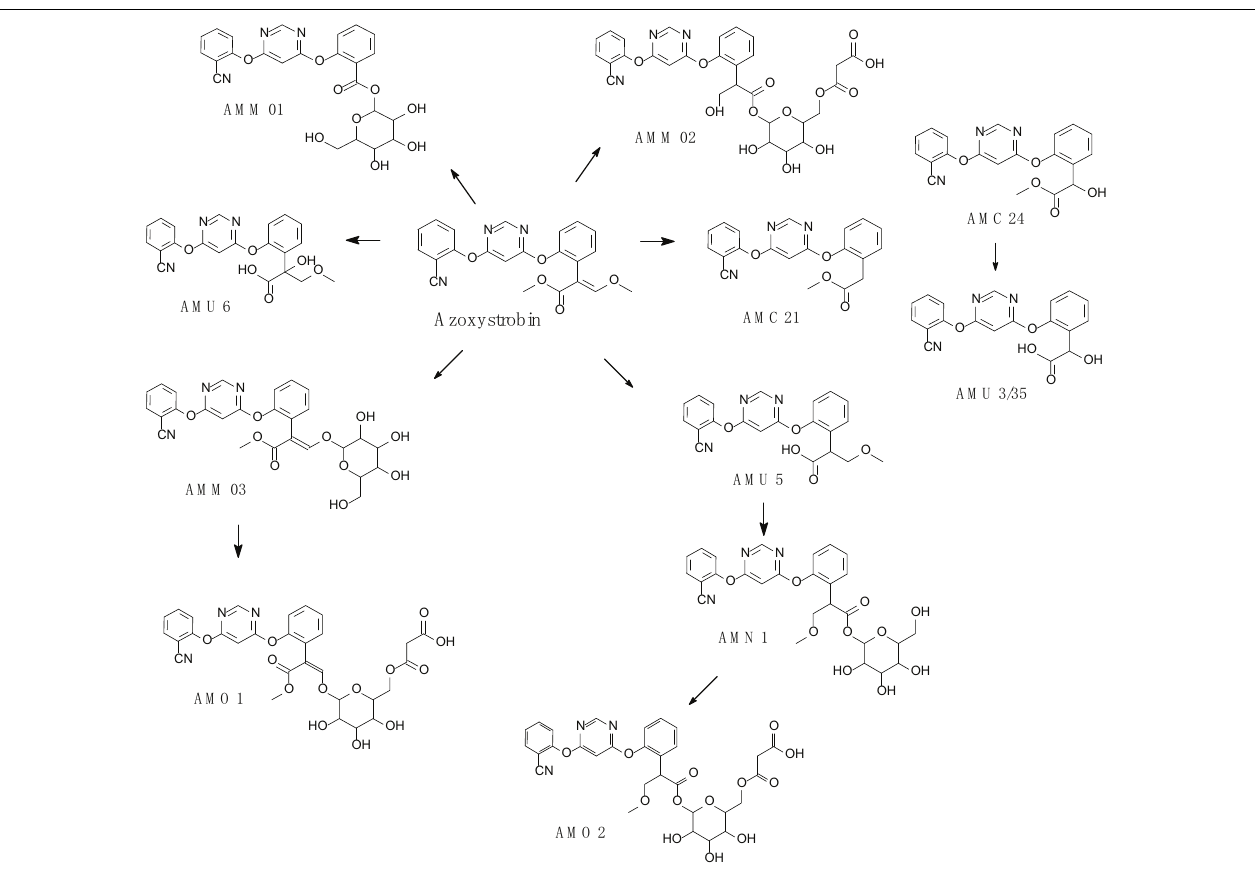
FIGURE 3 | Proposed degradation pathway of azoxystrobin in Brassica species (based on Bauer et al., 2018).